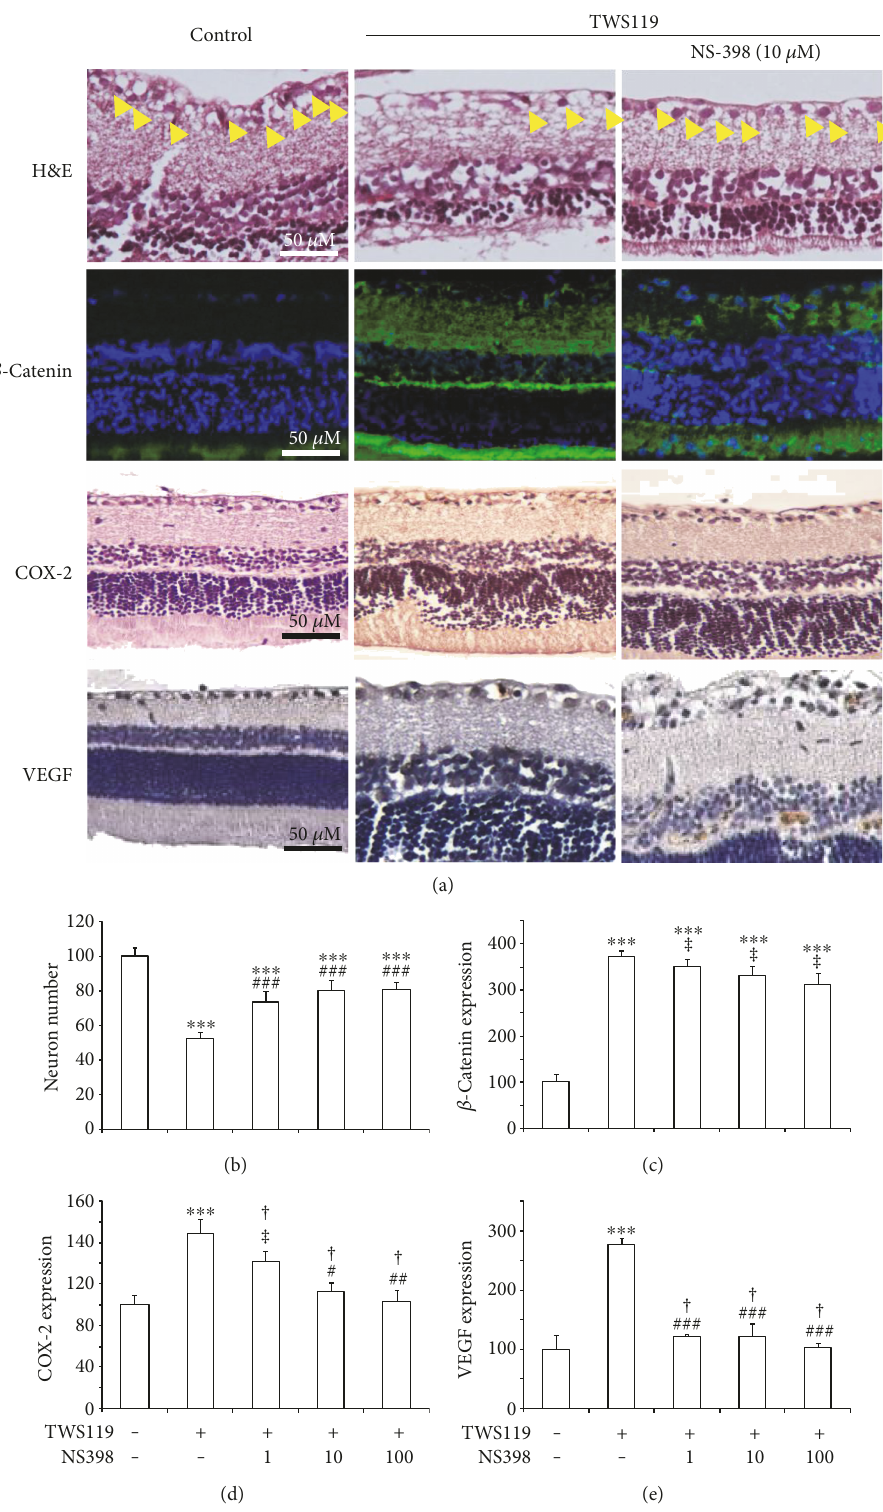
Figure 4: NS-398 could attenuate the TWS119-induced activation of β -catenin causing neuron cell loss. (a) Representative images (H&E staining, expression of β -catenin, COX-2, and VEGF) of the rats. (b) Neuron number of RGCs with respect to control (untreated), in TWS119-injected retinas of animals treated with NS-398. (c) β -Catenin expression of retinas with respect to control in TWS119-injected retinas of animals treated with NS-398. (d) COX-2 expression of retinas with respect to control in TWS119-injected retinas of animals treated with NS-398. (e) VEGF expression of retinas with respect to control in TWS119-injected retinas of animals treated with